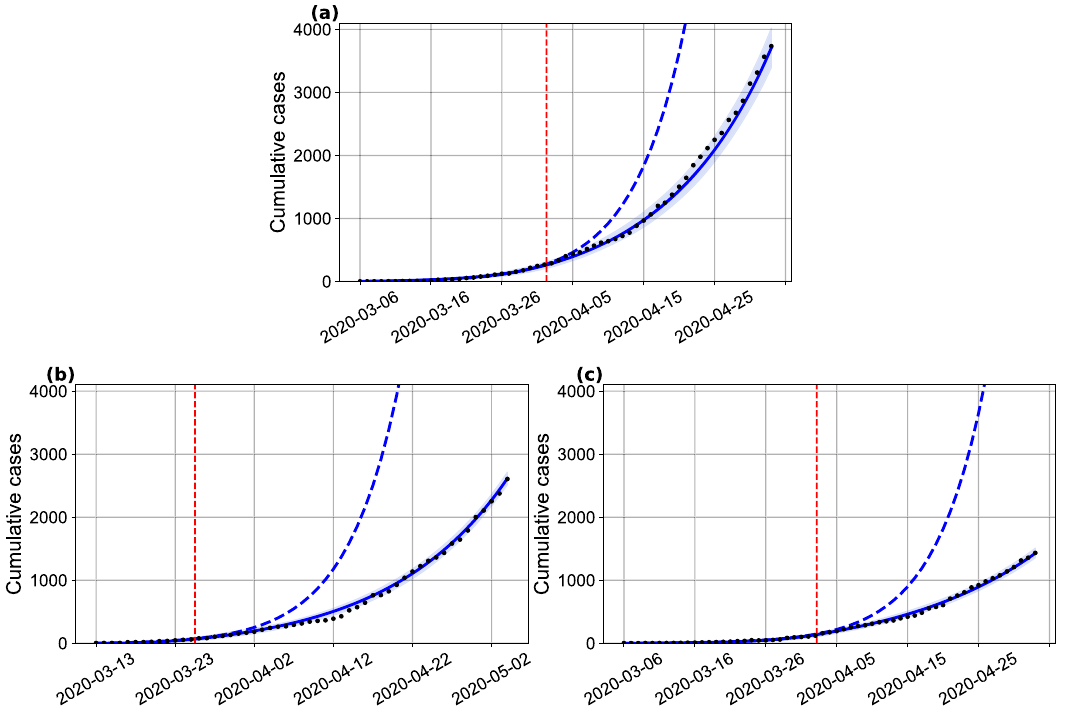
Fig. 1 Projection of the the number of cases with a changing transmission rate. ( a ) in Bahia; ( b ) in Salvador, and ( c ) in the remaining 416 municipalities. The parameters κ = 1/4, p = 0.2, γ a = 1/3.5, γ s = 1/4 were fi xed and h was set to zero for the capital and inland cities. The black dots correspond to the actual number of cases. The vertical dashed red lines are the dates of transition from β 0 to β 1 . The blue dashed and full lines represent the evolution of the epidemic with a fi xed transmission rate β 0 and with both β 0 and β 1 , respectively. The shaded error bands represent 95% con fi dence intervals of the mean calculated using the weighted non-parametric bootstrap method. Raw data from March 6 to May 4, 2020 are shown in this